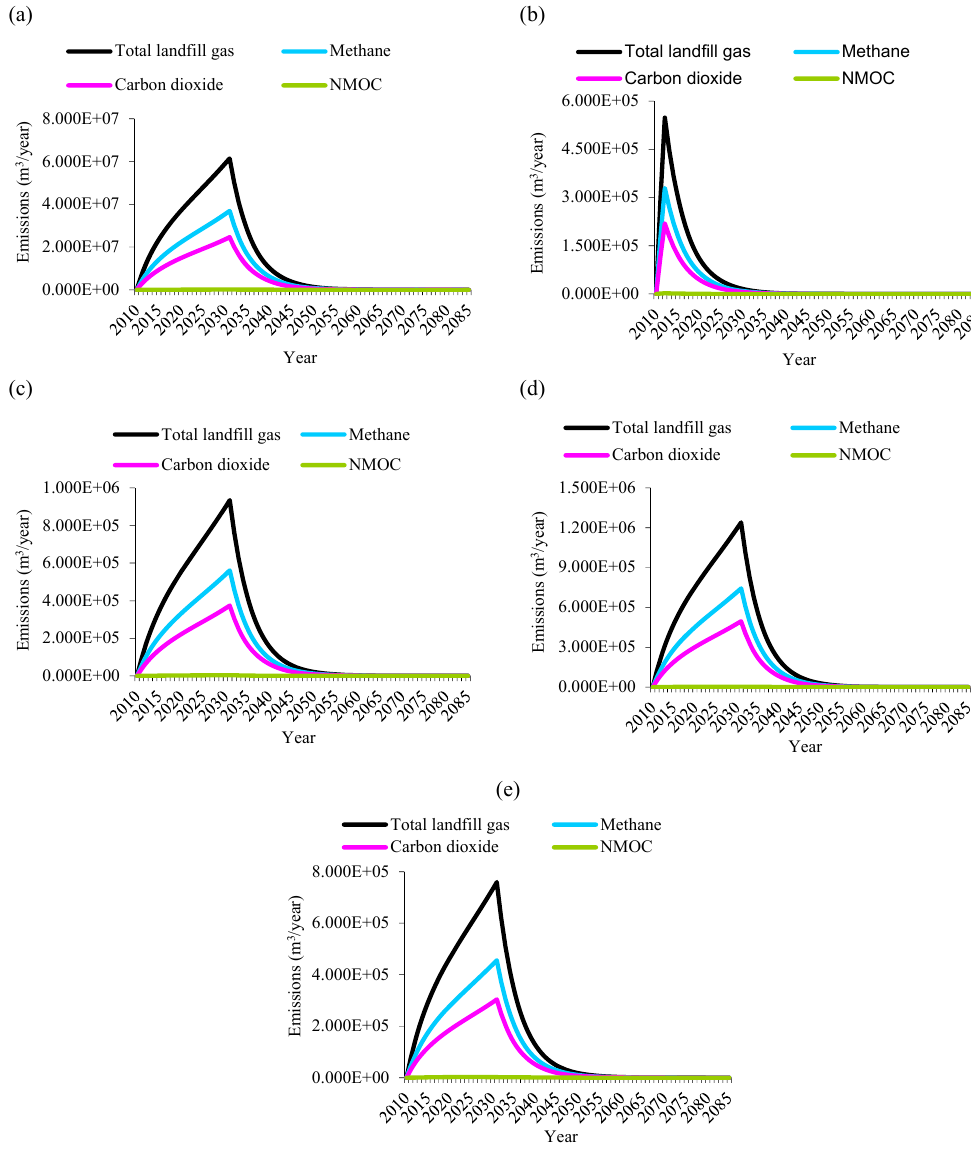
Fig. 2: The amount of gas emission from the study area during 2011 to 2030 (m 3 / year) in (a) Hamedan, (b) Bahar, (c) Joraghan, (d) Marianaj and (e) Lalejin